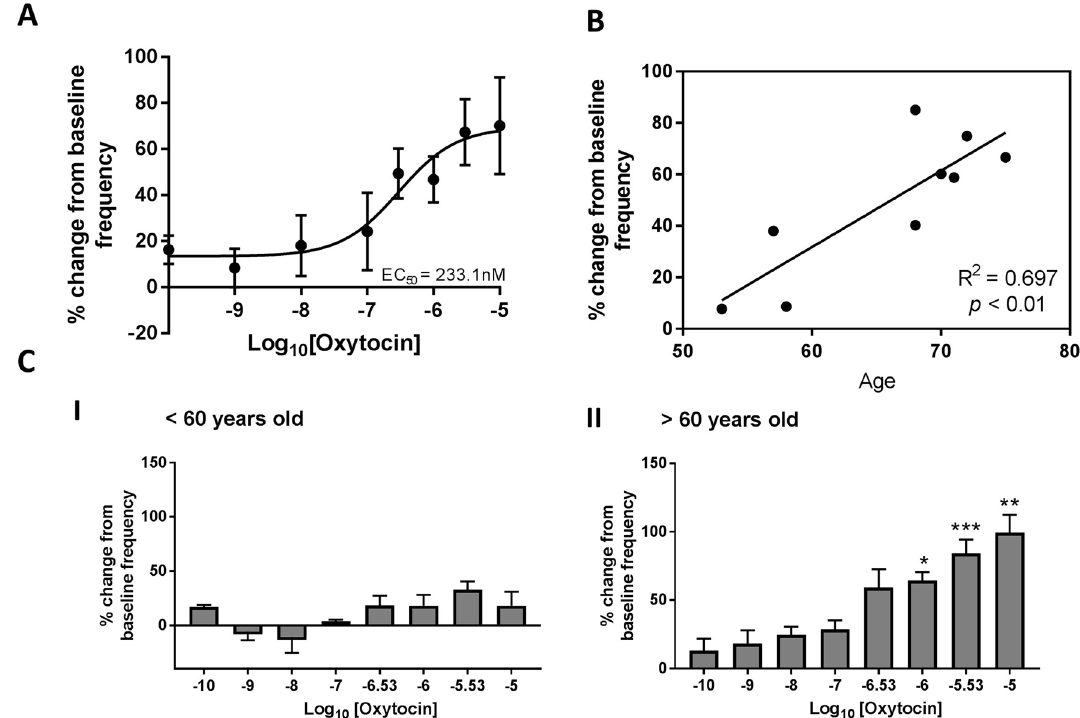
Figure 4. Variability in oxytocin induced change in spontaneous contraction frequency is significantly correlated with age. ( A ) Dose response curve of % change from baseline frequency with increasing concentration of exogenous oxytocin (n = 9, non-linear regression). ( B ) Correlation between % change from baseline frequency and age (n = 9, Linear Regression analysis, p < 0.05 considered significant). ( C ) % change from baseline frequency in response to increasing concentrations of exogenous oxytocin from prostate tissue collected from men (I) less than 60 years old (n = 3), and (II) greater than 60 years old (n = 6) (paired one-way ANOVA with Dunnets multiple comparisons test, * p < 0.05, ** p < 0.01, *** p <